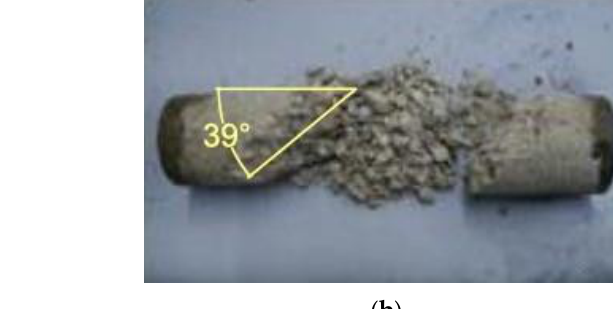
Figure 6. Stress-deformation diagrams for test series P0, PE, A10 and A20, including the applied hydraulic pressure for test series A10 and A20.